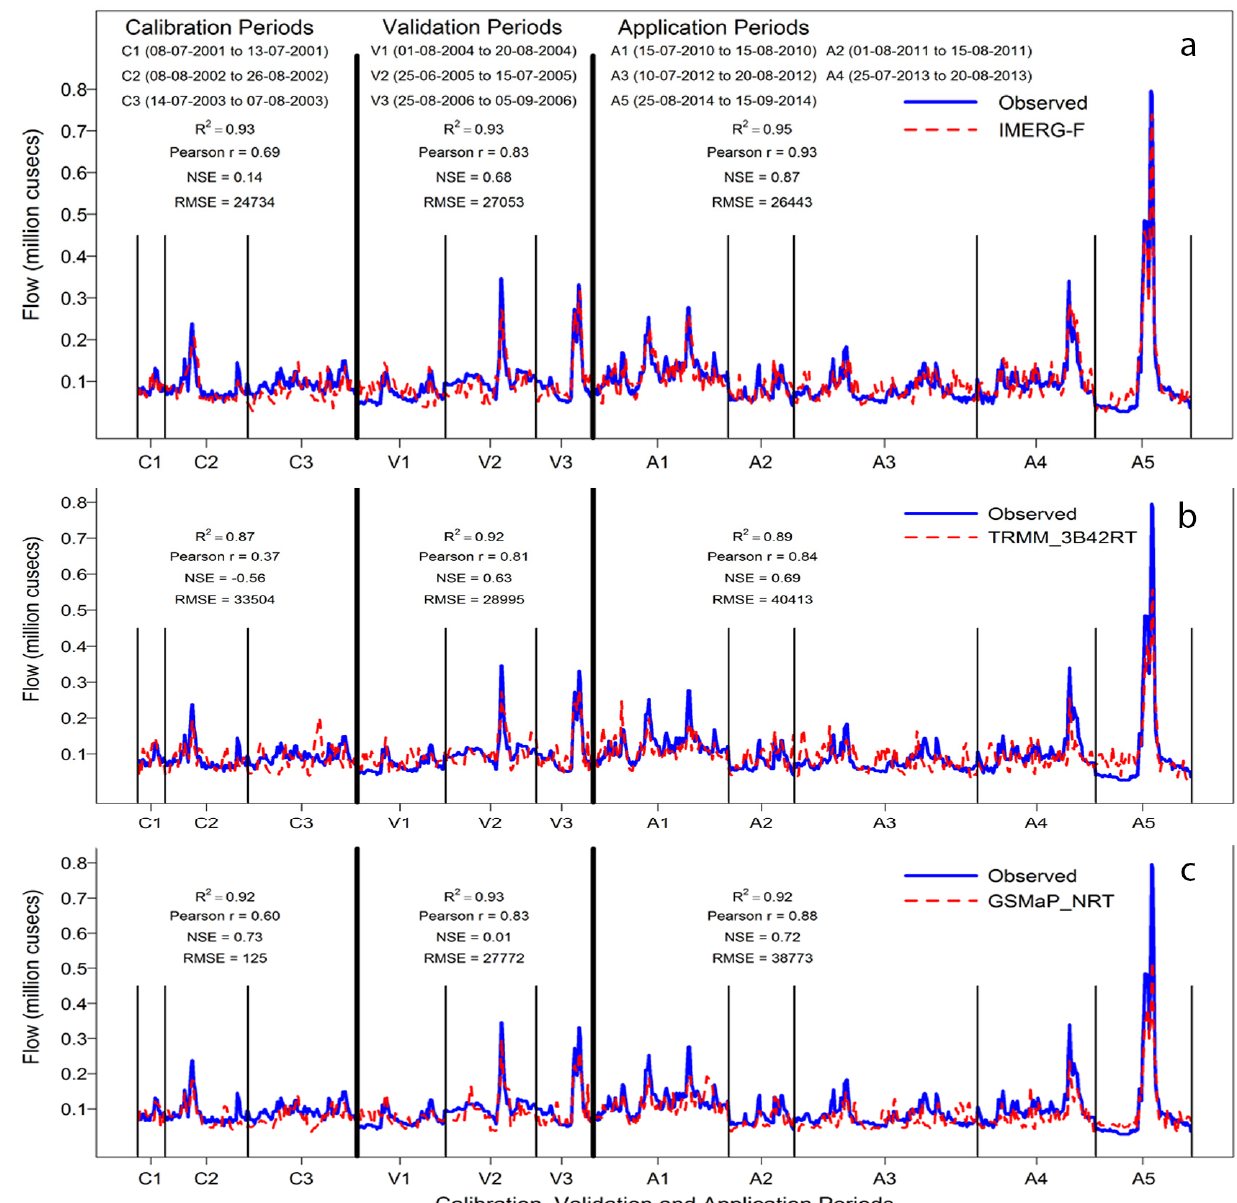
Figure 3. ( a – c ) Comparison of simulated and observed flows at the Marala barrage for calibration, validation, and application periods: ( a ) IMERG-F, ( b ) TRMM_3B42RT, and ( c ) GSMaP_NRT.